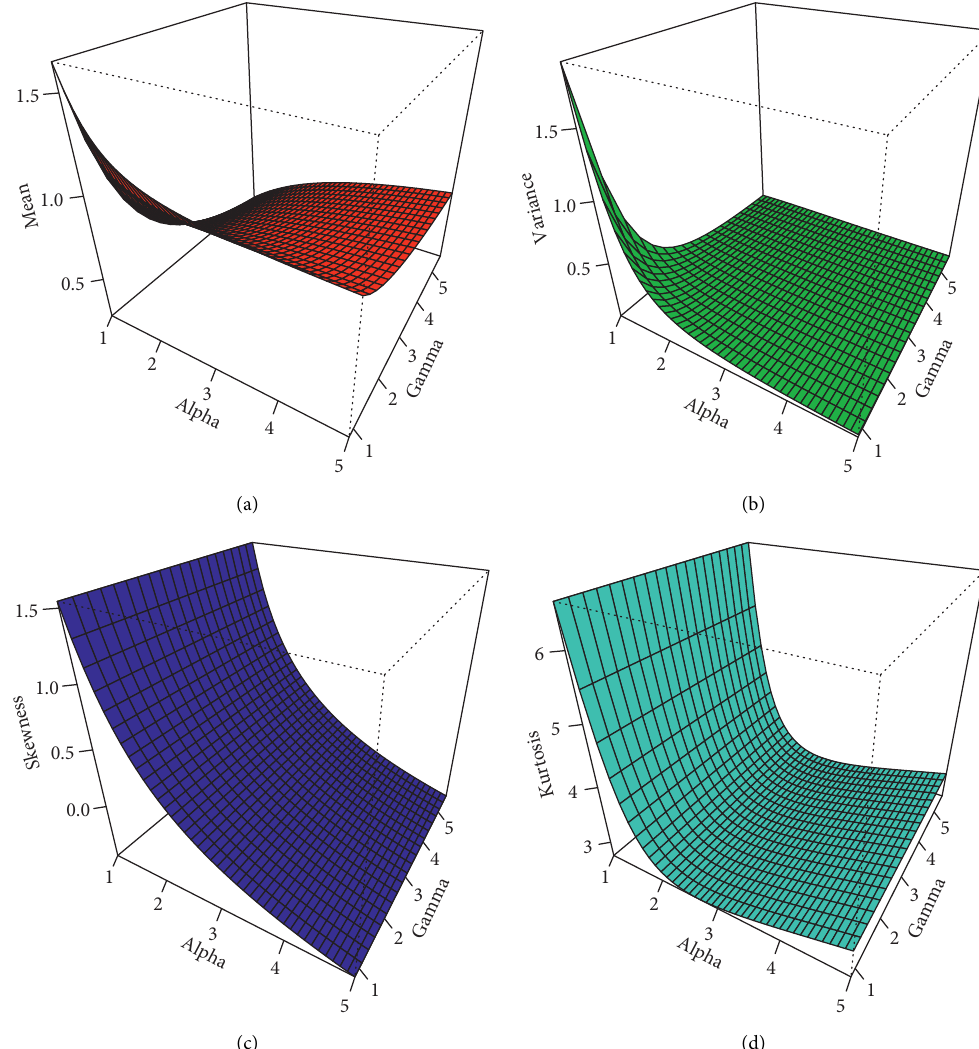
Figure 4: Plots for the (a) mean, (b) variance, (c) kurtosis, and (d) skewness of the ASNFEW